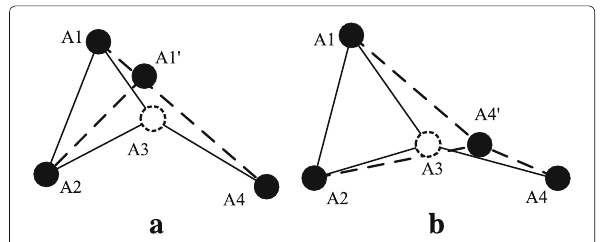
Theorem 5 The shorter distance a node travels, the fewer nodes are affected. The probability of a node affected by its moving neighbor is ( 1 − 2 θ − sin2 θ π ), where θ = arccos d / 2 R c , d is the travel distance, and R c is the commu- nication range. It approximately equals 0.62 times of d / R c